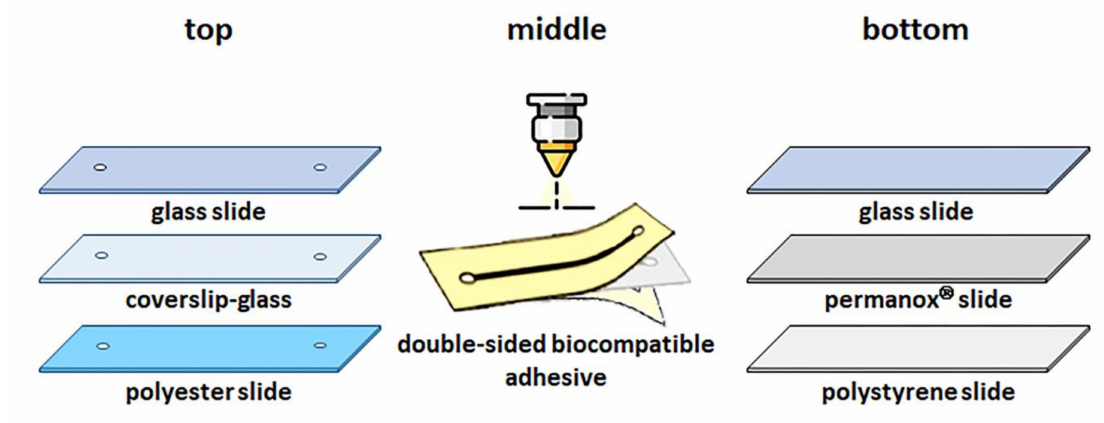
Figure 2. The biocompatible adhesive microchip fabrication is based on using a double-sided biocompatible adhesive to join the top and bottom layers. Top layer: glass slide, coverslip, or polyester). Middle layer: cut double-sided biocompatible adhesive. Bottom layer: glass slide, Permanox ® , or polystyrene film. The top of the microchip is a female luer glued to facilitate the silicone hose fitting for microfluidic